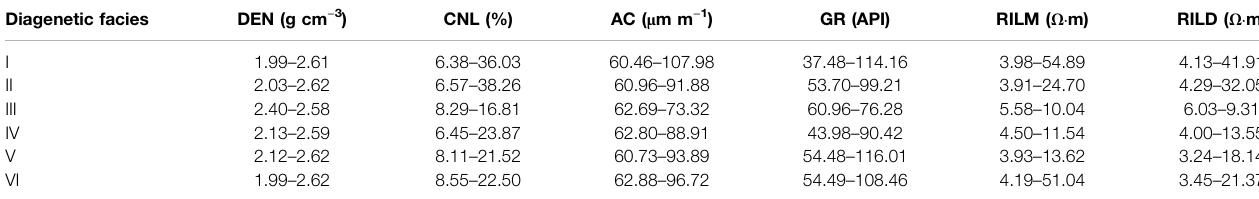
TABLE 3 | Bore log responses for samples of different diagenetic facies. Diagenetic facies